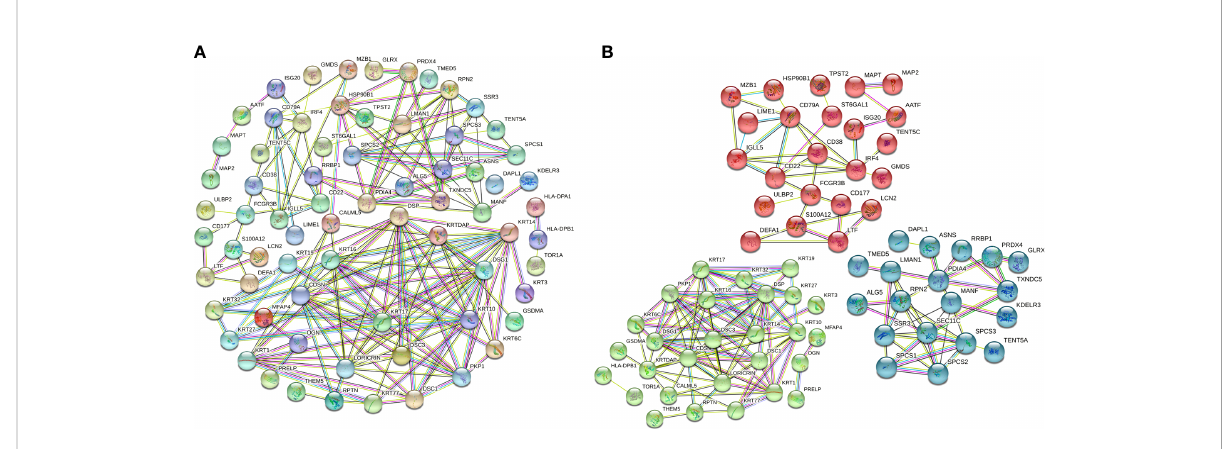
FIGURE 3 PPI network and subnetwork of DEPs. (A) PPI network of 115 DEPs constructed using STRING. (B) Functional sub-network analysis of the PPI